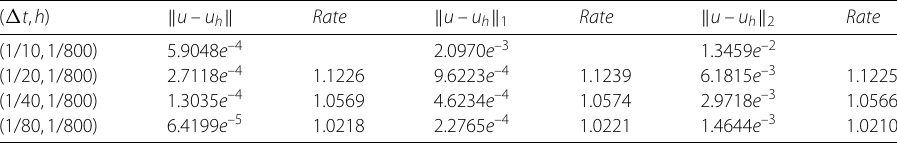
Table 2 The error for different time step (cid:3) t at t = 1